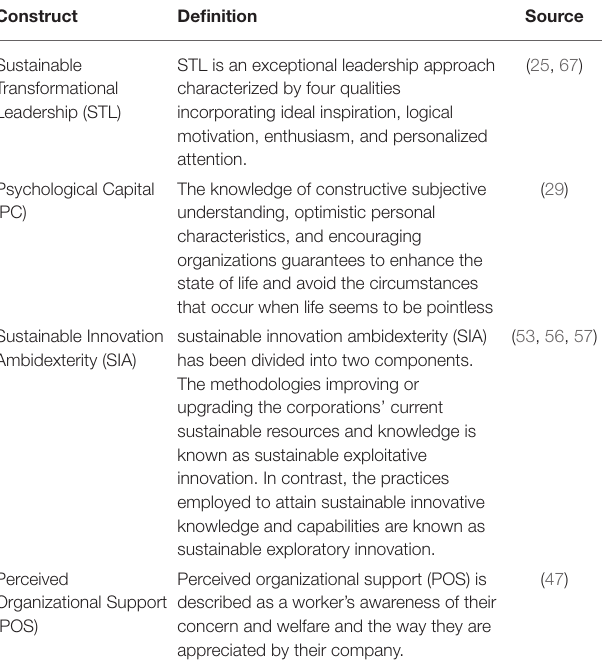
TABLE 1 | Operational definitions. TABLE 2 | Construct validity and